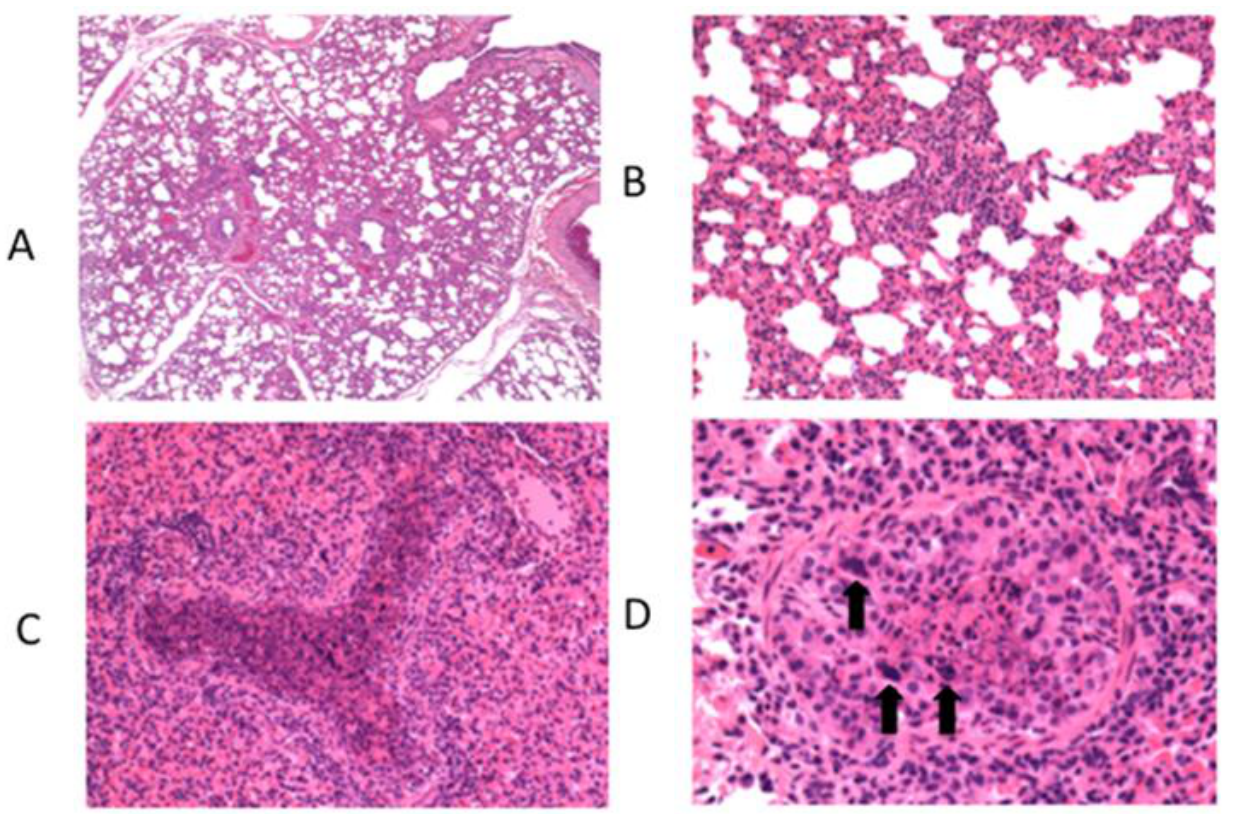
Figure 2. Histological lesions observed in lung of calves after experimental infection with bovine RSV. Calves were challenged via aerosol with bovine RSV. On day 7 post-infection, samples of lung were collected for histological evaluation. A representative image from a single calf is shown. ( A ) Moderate interstitial thickening and wide interlobular septae due to edema. Original magnification, 4X. ( B ) Alveolar septae are thickened due to cellular infiltrates found to be macrophages, lymphocytes and lesser numbers of neutrophils when viewed at higher magnification. Original magnification, 20X. ( C ) Bronchioles are filled with neutrophils, sloughed epithelial cells, and necrotic cell debris. Original magnification, 20X. ( D ) There is partial to complete loss of bronchiolar epithelial cells with attenuation of remaining cells. In some bronchioles, epithelial cells form multinucleated syncytial cells (arrows). Original magnification, 40X. Figure adapted from: